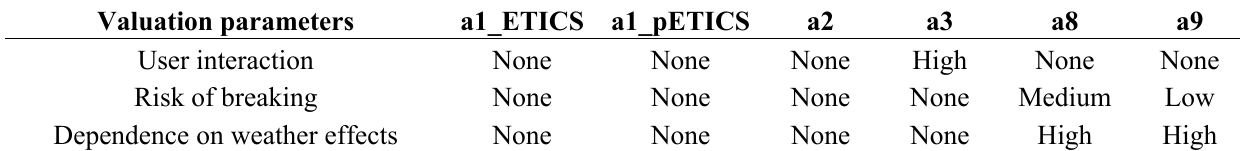
Table 7. Qualitative evaluation of the reduced